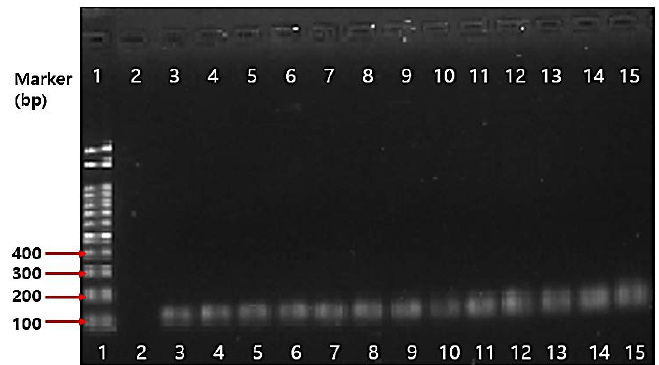
Figure 2. PCR analysis results of various Bifidobacterium spp.: Lane 1: marker; Lane 2: without loading; Lane 3: B. lactis AS60; Lane 4: B. bifidum KCTC 3440; Lane 5: B. longum BORI; Lane 6: B. longum KCCM 91563; Lane 7: B. lactis BB-12; Lane 8: B. longum RD47; Lane 9: B. bifidum BGN4; Lane 10: B. thermophilum KCCM 12097; Lane 11: B. adolescentis ATCC 15703; Lane 12: B. lactis AD011; Lane 13: B. infantis ATCC 15697; Lane 14: B. breve M-16V; Lane 15: B. animalis ATCC 25527.